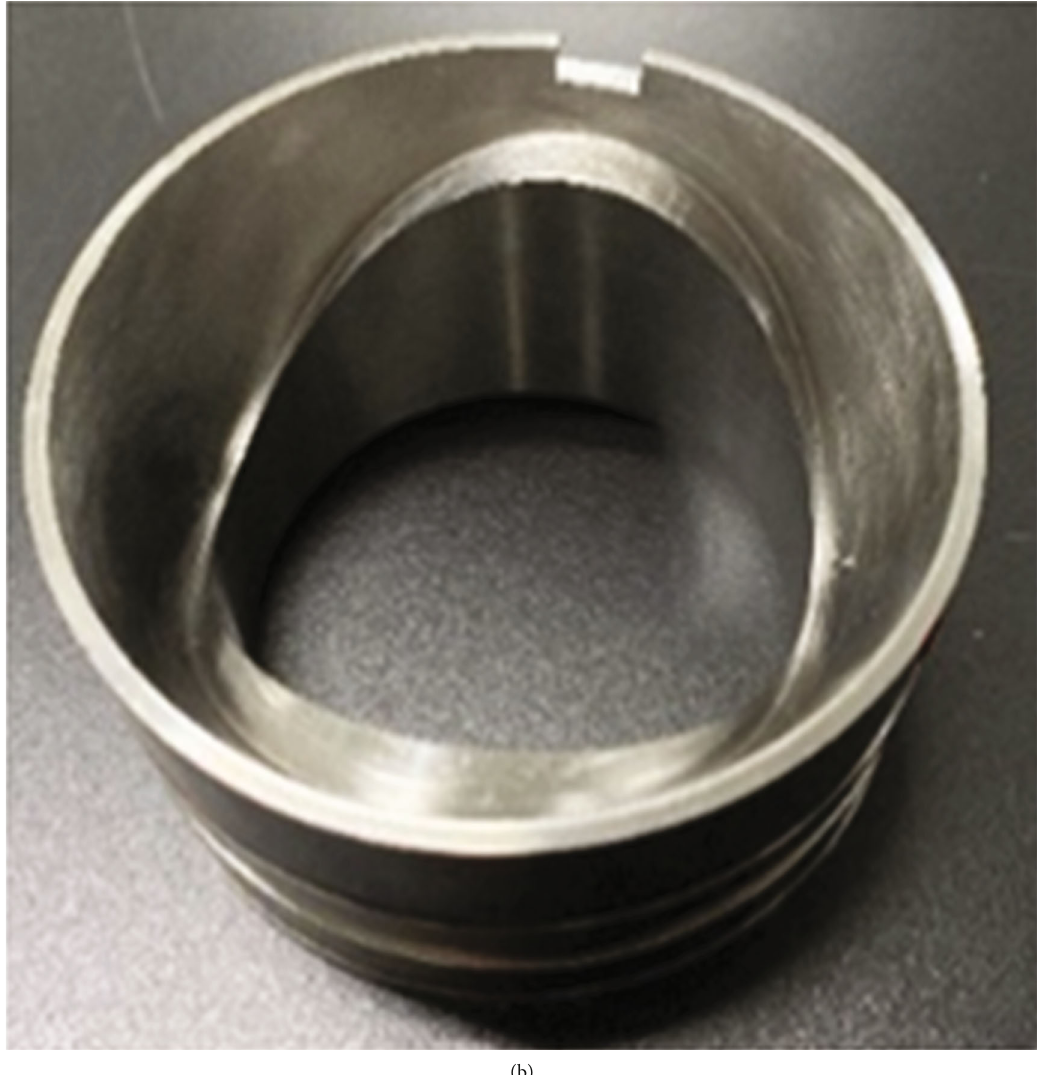
Figure 12: Experimental objects. (a) Conical sealing structure. (b) Wedge sealing